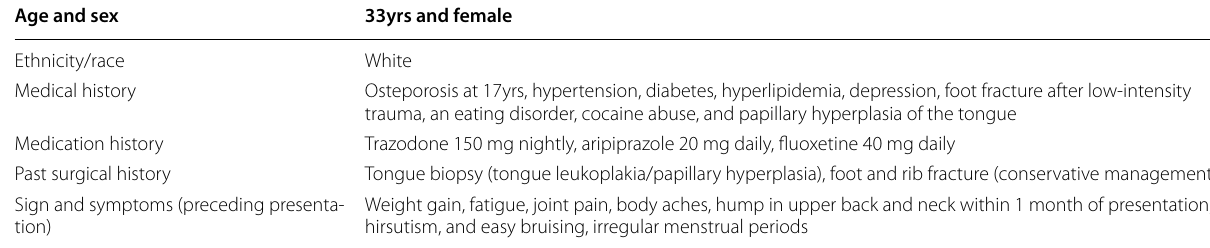
Table 1 Patient characteristics Age and sex